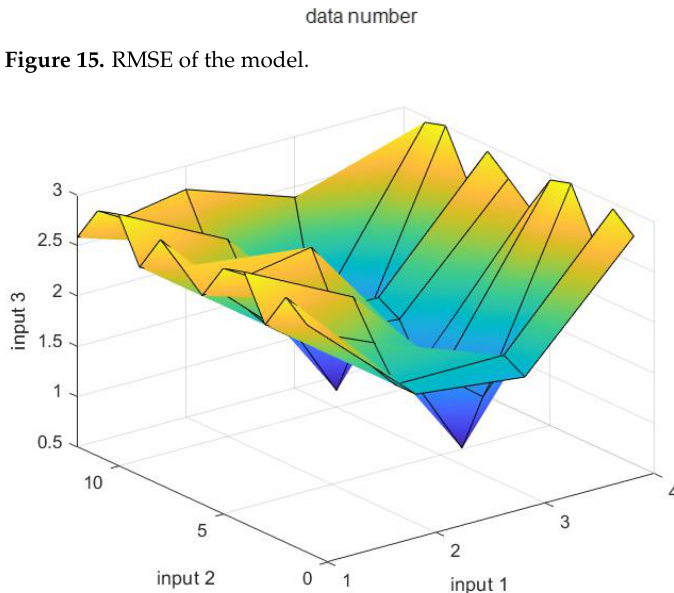
Figure 16. 3D plot of ANFIS-ELM.